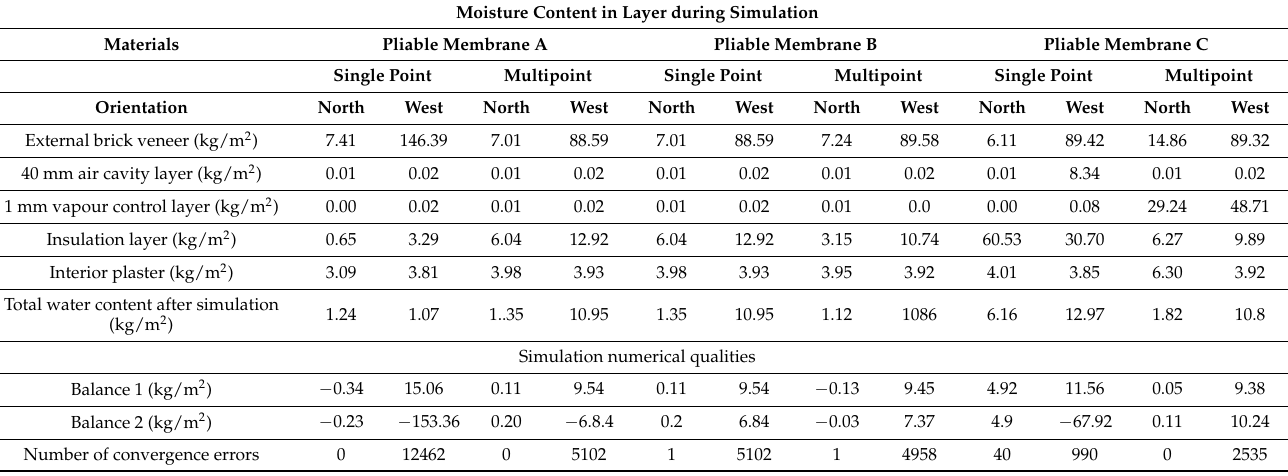
Table A5. Hygrothermal calculation result for Holzkirchen with wind-driven rain